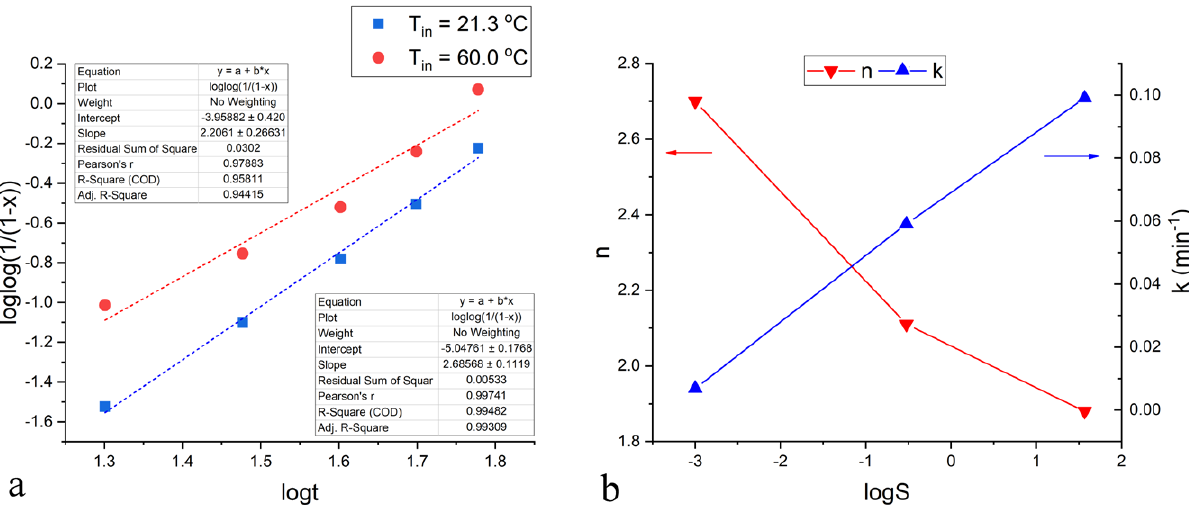
Figure 3. Linear fits of kinetic data for the crystallization of DI water depending on the initial temperature of its exposure to the at -18 o C environment using the Johnson-Mehl-Avrami-Kolmogorov method (a). Dependence of the Avrami exponent, n , and the kinetic constant, k , on the salt concentration in water for the water samples introduced to the -18 o C environment with the initial temperature of 21.3 o C (b). The salinity of DI water was arbitrarily set to 0.001 mg/ml so that it can fit the logarithmic graph.